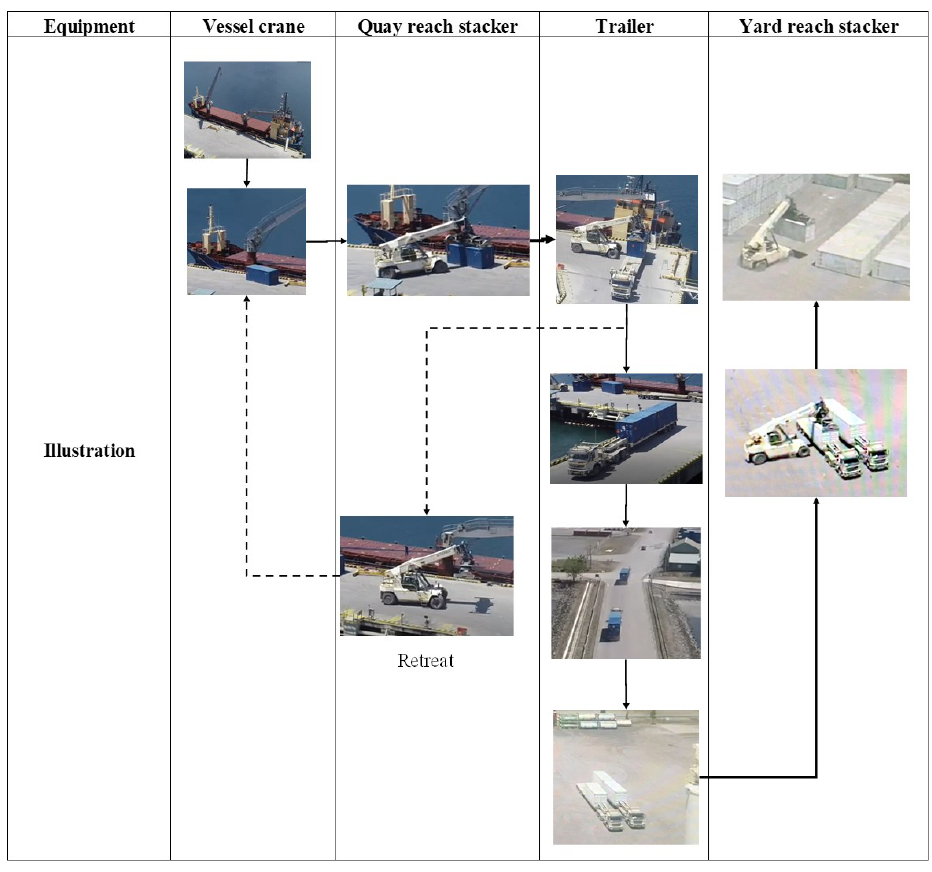
Figure 3. Handling process for container